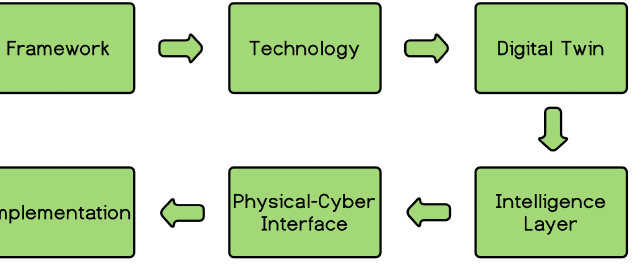
Figure 2. Methodology utilized for the development of the DT architecture for CEA systems. The rep- resentation has been adopted from